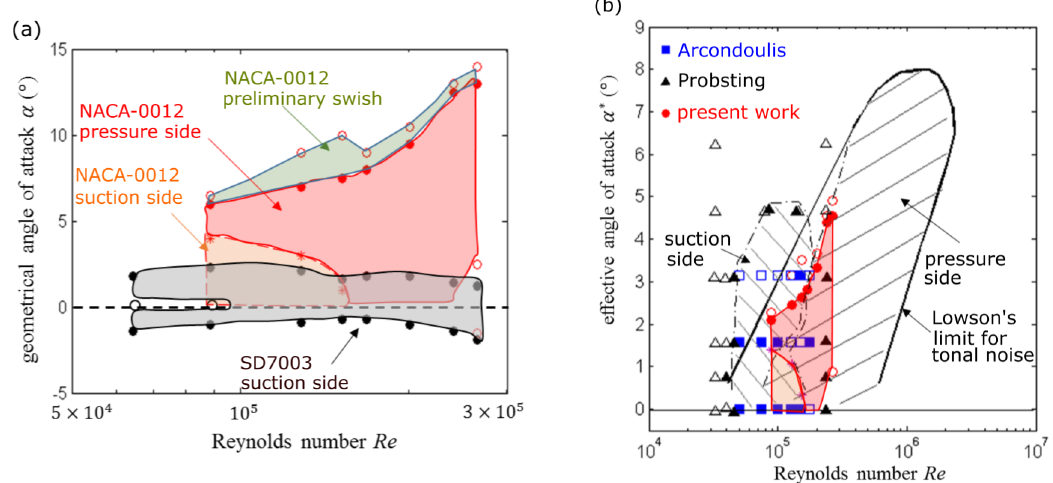
Figure 9. ( a ) Geometrical angle-of-attack (AOA) vs. Re tonal noise map from [15] for NACA-0012 and SD7003 airfoils. Filled circles show the limits of the tonal-noise regime; empty circles point to the onset of low-amplitude noise. Green area is the primary emission for the NACA-0012 airfoil, red and orange areas are tonal noise generated by pressure or suction sides of the NACA-0012, respectively, and grey area is tonal noise generated by suction side of SD7003 airfoil. ( b ) Effective AOA vs. Re tonal noise map from [15] for NACA-0012 airfoil, compared with previous investigations (see also Figure 4).